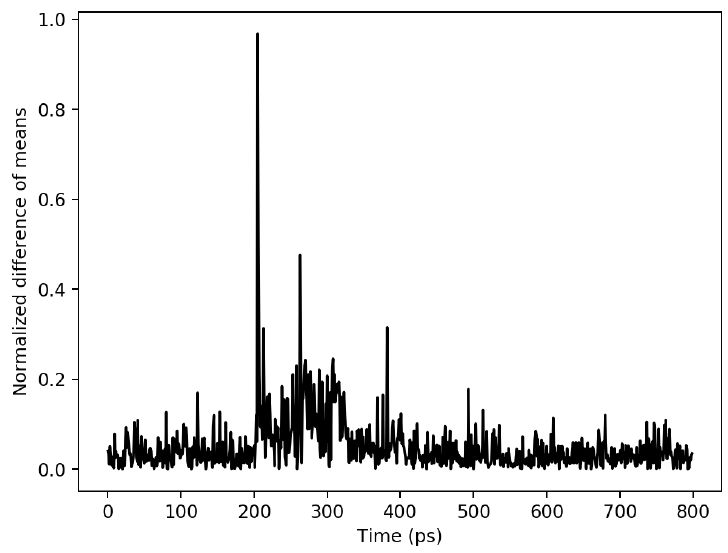
Figure 10. Differential power analysis on ASIC design with 100,000 traces.